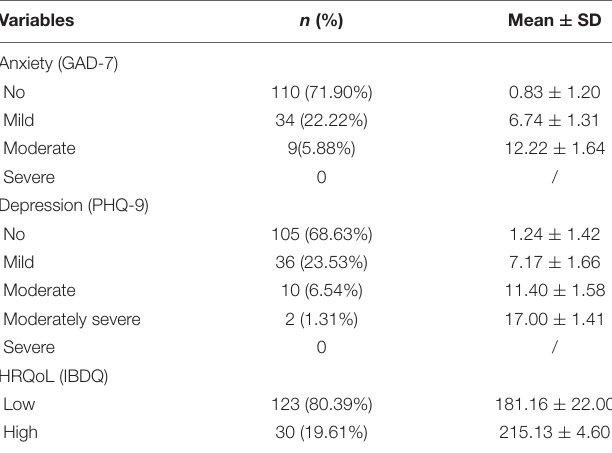
TABLE 3 | Level of anxiety, depression, and HRQoL among CD